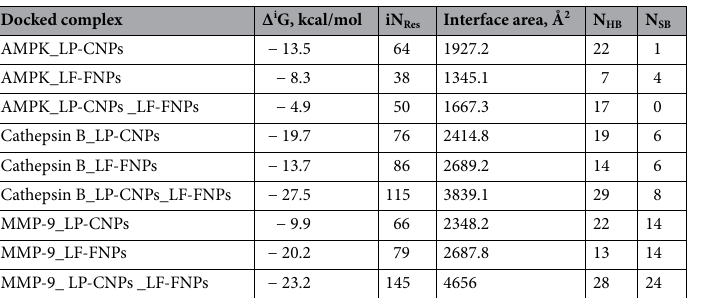
Table 3. PDBePISA web server outcomes for the studied docked complex interfaces. ΔG, binding affinity; i N res , residues number; N HB, potential hydrogen bond number; and N SB, potential salt bridge number.